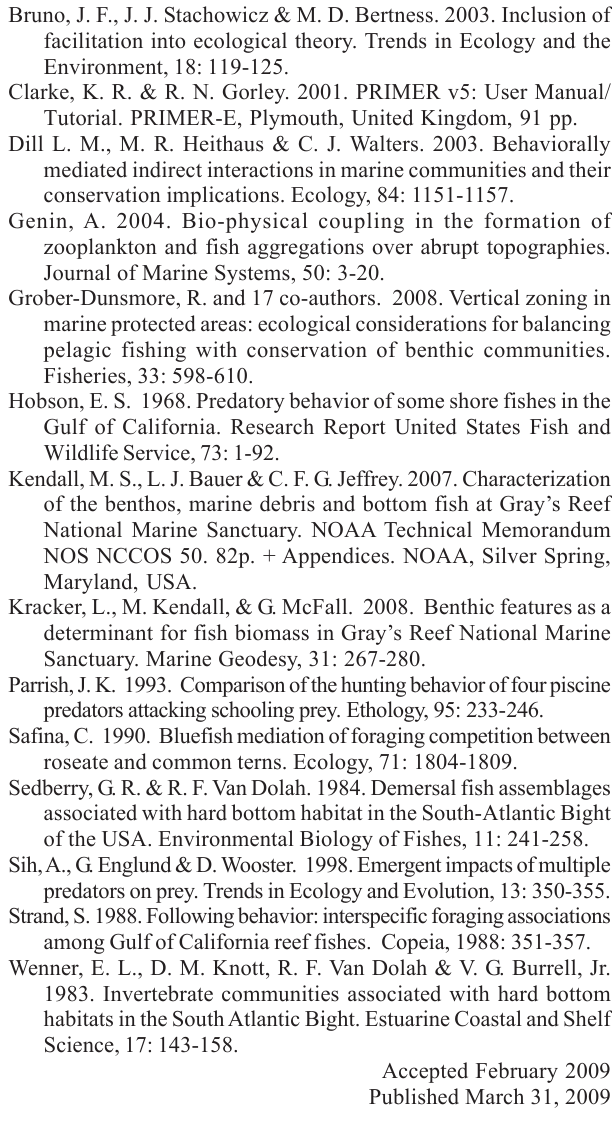
Fig. 3. Results of hierarchical clustering using the group average linkage method. The dendrogram illustrates variable strengths in multi-species relationships and patterns of species groupings (species codes as in Table